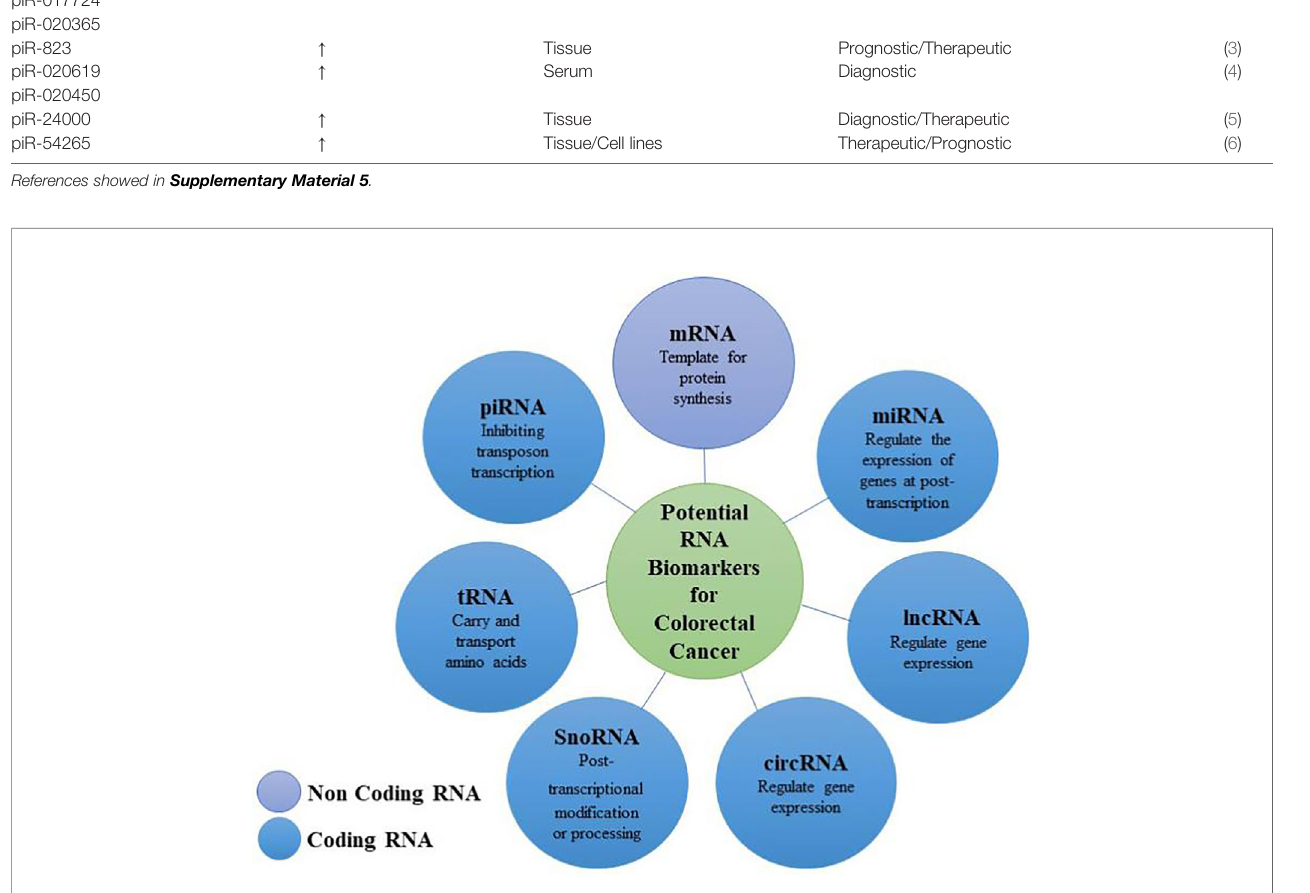
FIGURE 1 | Biomarkers (mRNAs and non-coding RNAs) for the diagnosis and prognosis of colorectal